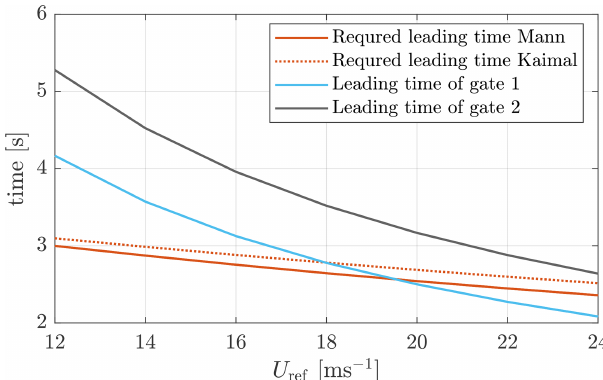
Figure 8. The leading time and required leading time for pitch feed- forward